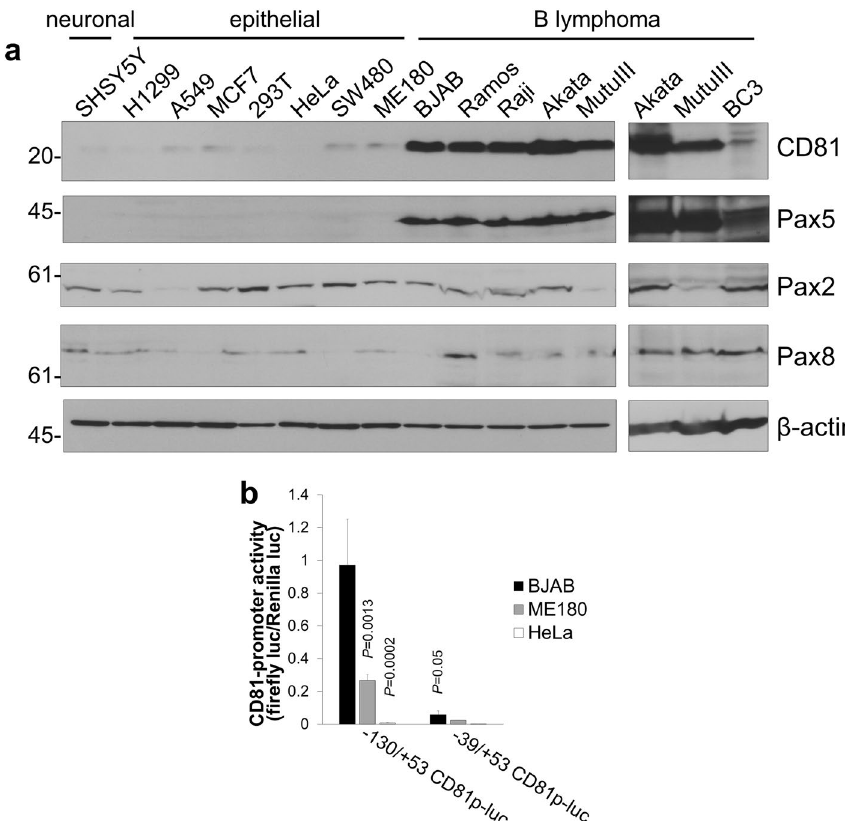
Figure 5. Expression levels of CD81 and Pax5 in human tumor cells. ( a ) Expression of CD81 and Pax5 proteins in human neuronal (SHSY5Y), epithelial (H1299, A549, MCF7, 293T, HeLa, SW480, and ME180), and B-lymphoma (BJAB, Ramos, Raji, Akata, MutuIII and BC3) cells. Each cell extract was subjected to Western blotting using anti-CD81, anti-Pax5, anti-Pax2 and anti-Pax8 antibodies. When we detected CD81 by anti-CD81 antibody, the sample buffer without 2-mercaptoethanol for the sample preparation was used. Original images of Western blotting are shown in Supplementary Fig. S4. The long exposure images of CD81 and Pax5 blotting using ME180, H1299, and HeLa cells are shown in Supplemental Fig. S5. ( b ) The transcriptional activity of the CD81 promoter in BJAB, ME180, and HeLa cells. Cells were transfected with CD81 proximal